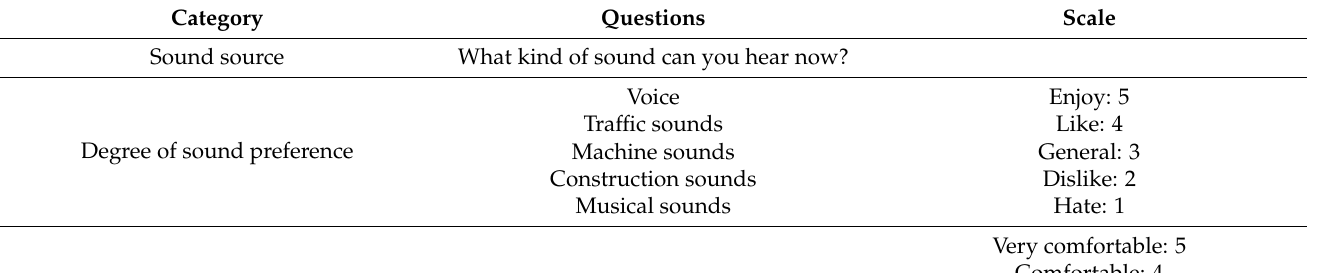
Table 1. Contents of the